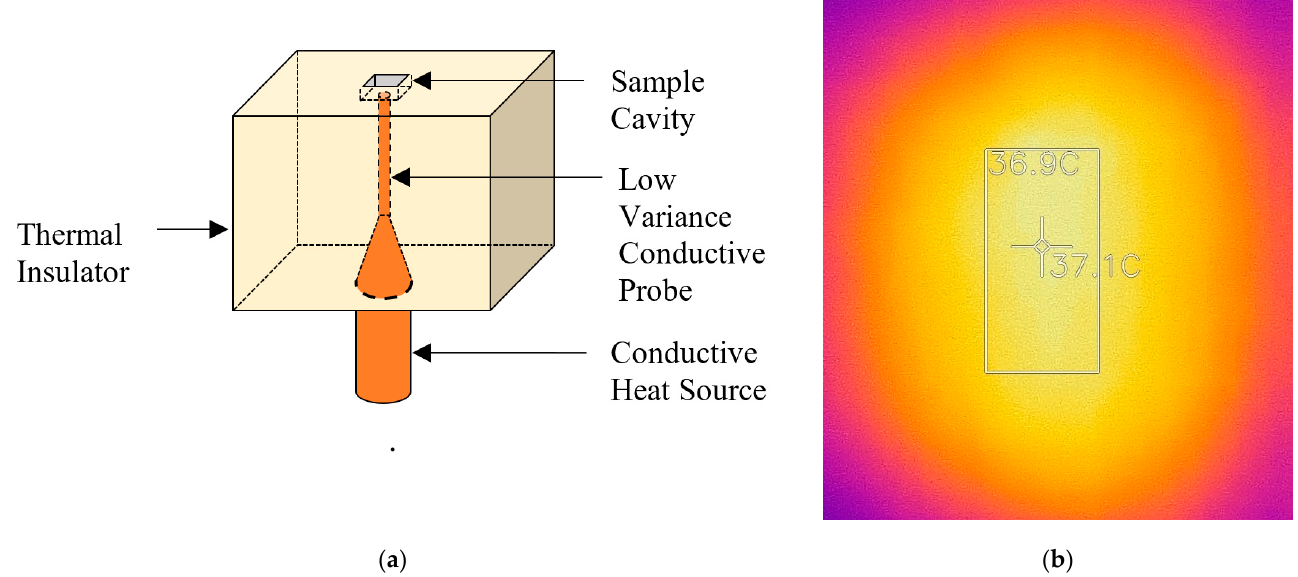
Figure 8. ( a ) Schematic of the low-variance heat source that is used in the experiments. ( b ) Sample IR image of the surface heat distribution of an MVA device; the box indicates the position of the MVA device.